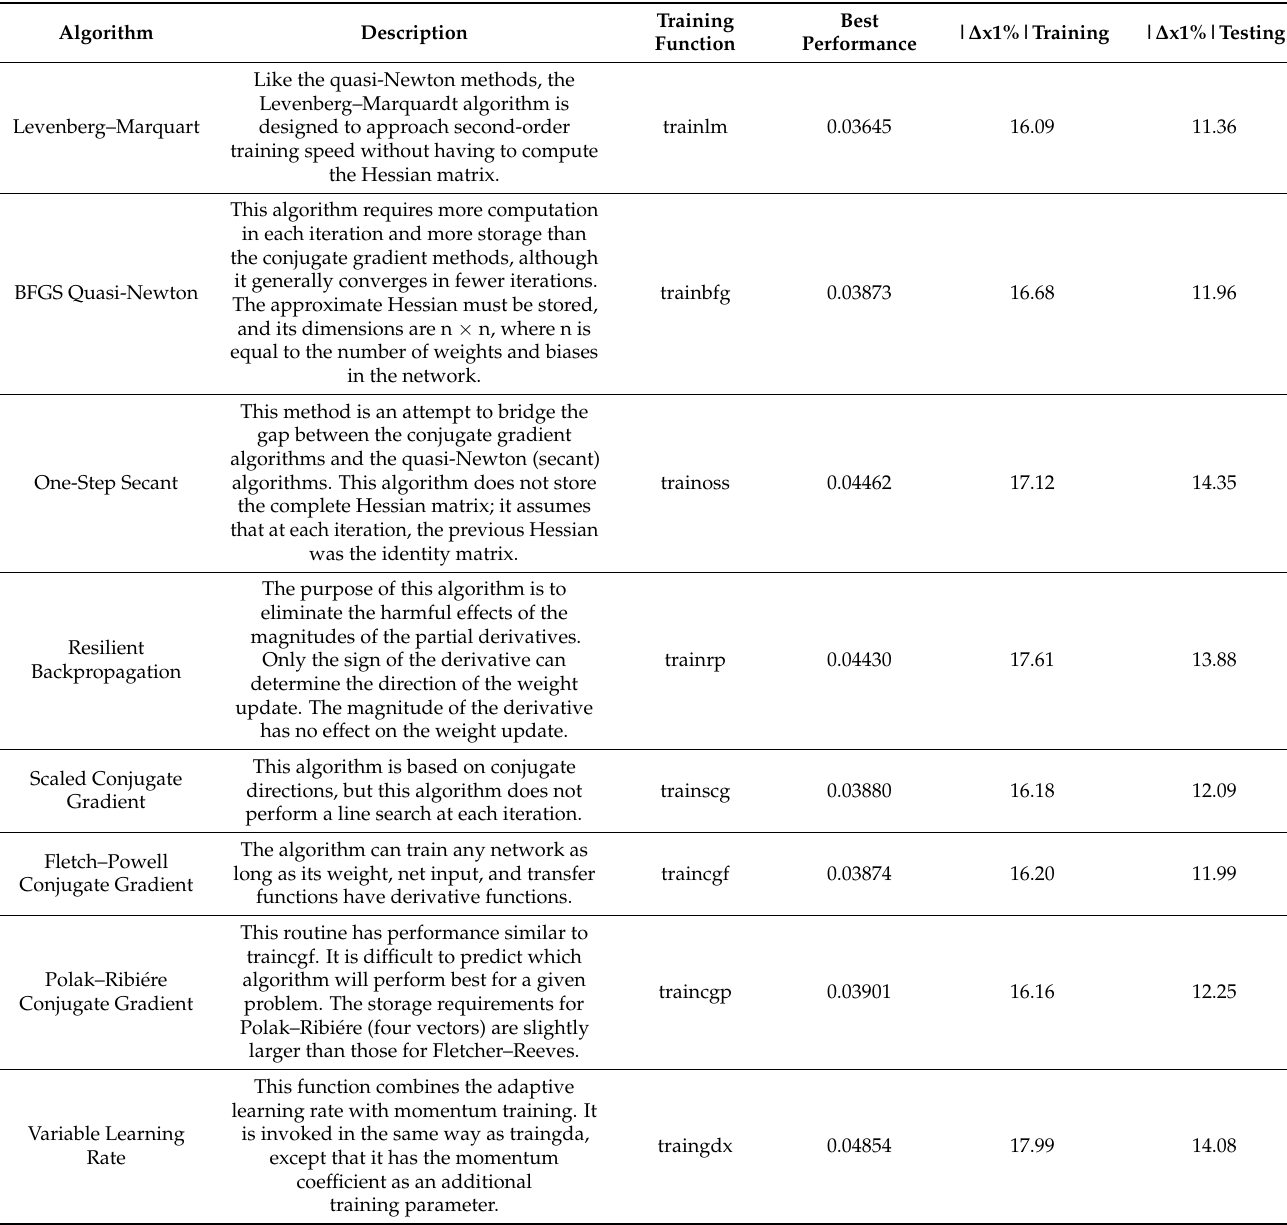
Table 3. Characteristics and results of the algorithms used in this